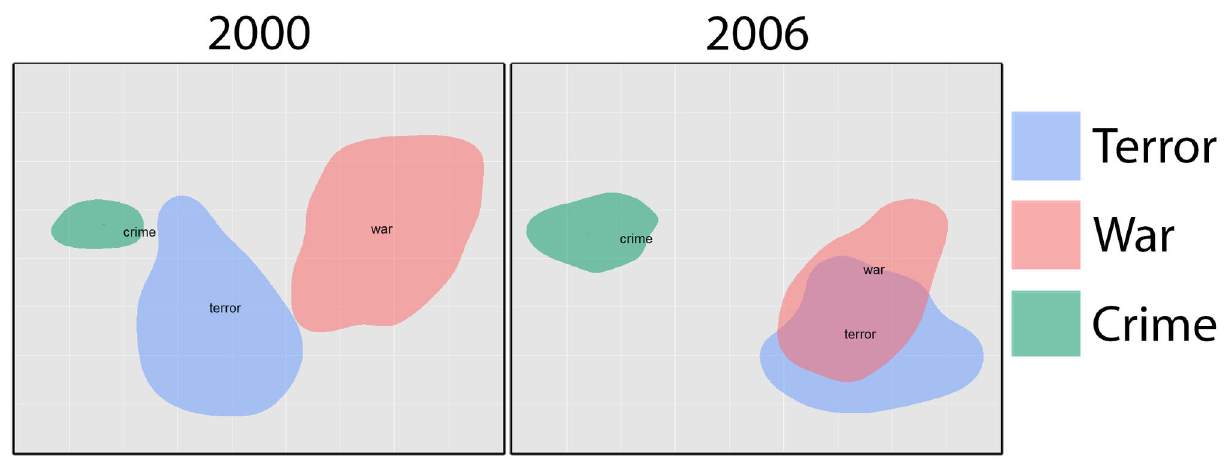
Figure 4. 2-dimensional visualization of the context vectors of war , crime , and terror . The distance between points in the visualized space represents the semantic distance between the points. That is, the further apart two regions of space are the more dissimilar they are. Overlap represents an overlap in the contexts of use for the two terms. These figures were extracted from Movie S1. The left frame is for June of 2000, and the right is for June of 2004. The data used in each frame is based on the 12 months starting with the indicated month. Because of memory constraints, context vectors for the 3 terms were aggregated by speaker for each month. This aggregated set of vectors was then used as a whole to compute the MDS, and plotted as a yearly running average on a month-by-month